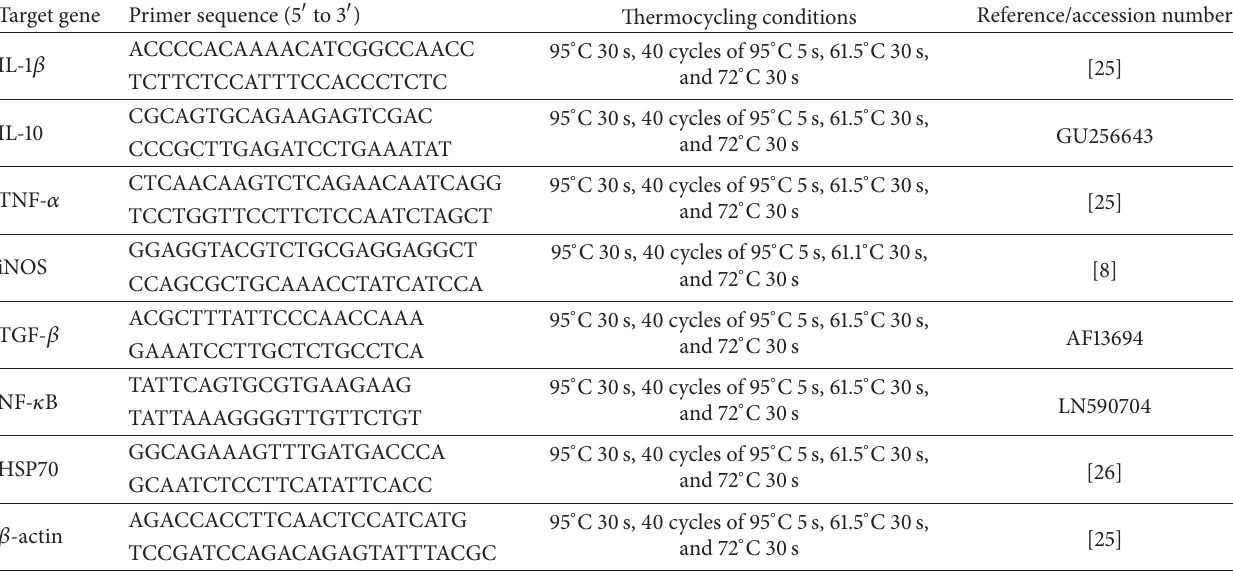
Table 2: Real-time primer sequences and thermocycling